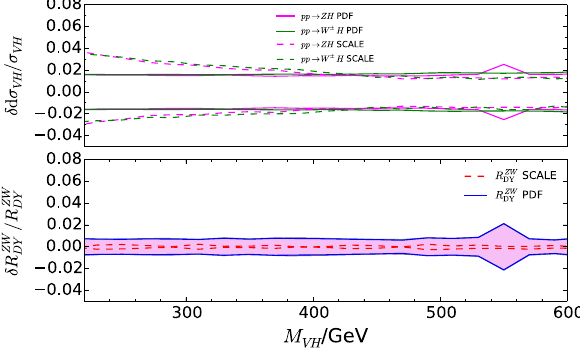
Fig. 7 PDF uncertainty from the Monte-Carlo replicas (using the PDF4LHC15_nlo_mc PDFsetwith α s ( M Z ) = 0 . 118[26])andrenor- malization/factorization scale uncertainty ( μ F = μ R varied by a factor of two around M VH ), evaluated assuming full correlation between WH and ZH , and using MC@NLO events with one emission added from the parton shower. This treatment is formally equivalent to an NLO calcu- lation (see main